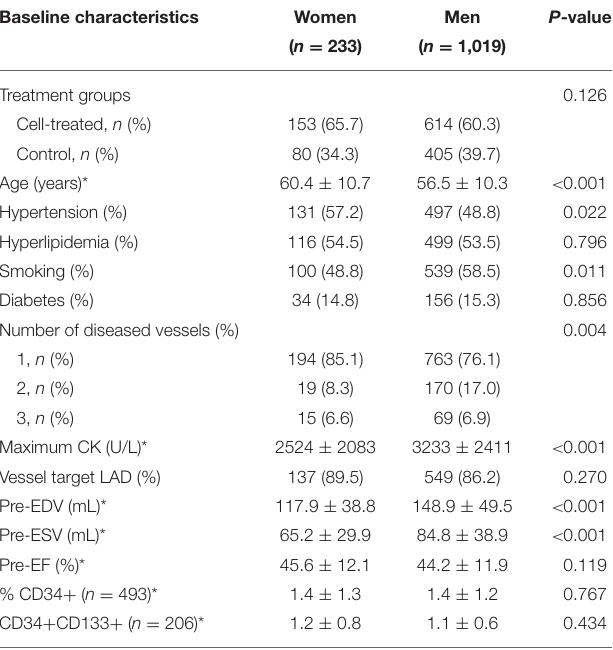
TABLE 2 | Baseline characteristics of patients stratified by